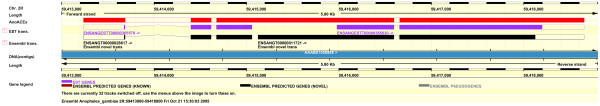
Annotation of AnoACE9. Ensembl ContigView display of the 59.413–59.419 Mb region of chromosome 2R showing AnoACE custom track annotation (red bar), Ensembl EST transcripts (ENSANGESTT) and Ensembl predicted transcripts (ENSANGT). The AnoACE9 gene consists of 4 exons. Exons 3 and 4 both contain ACE active site coding regions and are spanned by cDNA 19600449703686 (ENSANGESTT00000365630) indicating a double-domain enzyme.